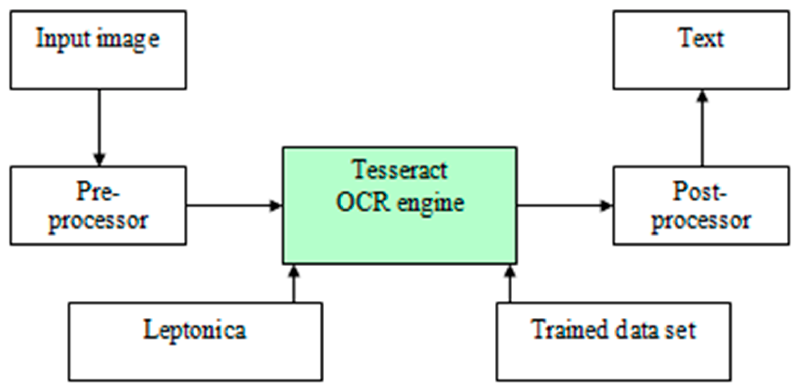
Figure 8. Tesseract process flow.